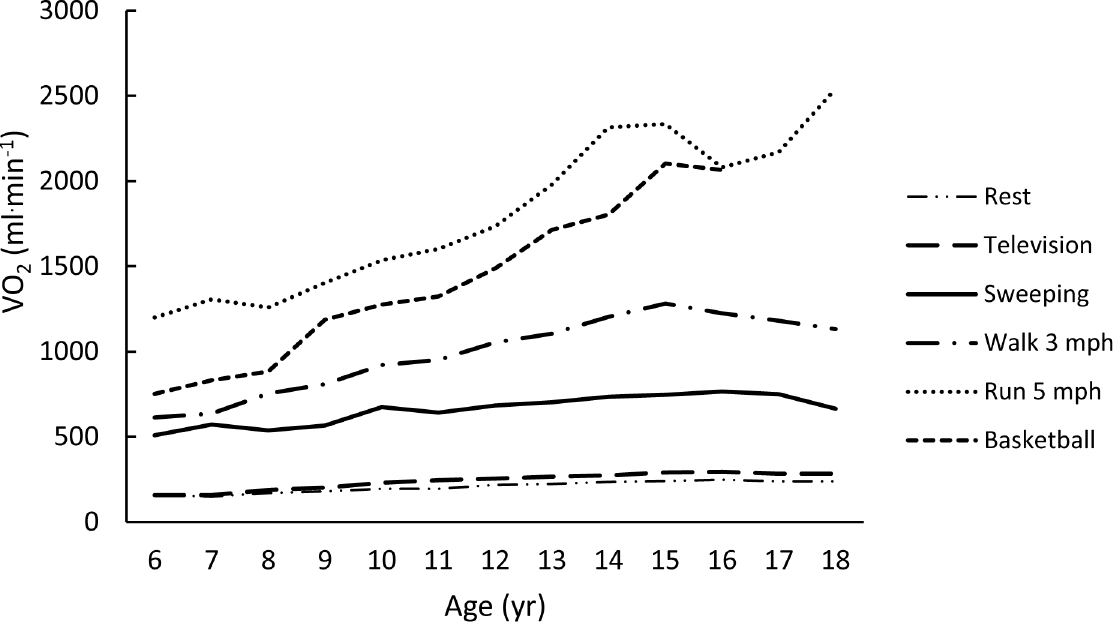
Fig 1. The relationships between age and absolute VO 2 (ml . min -1 ) for six activities representing various intensities of physical activities.